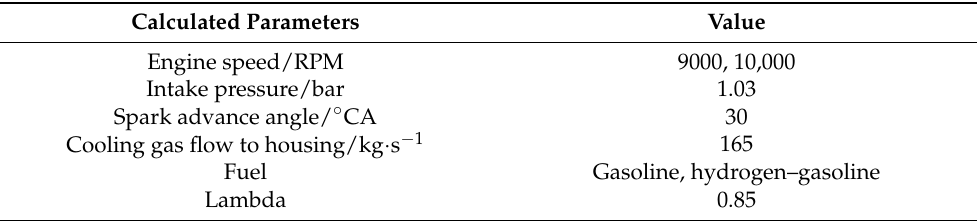
Table 2. Calculated initial conditions